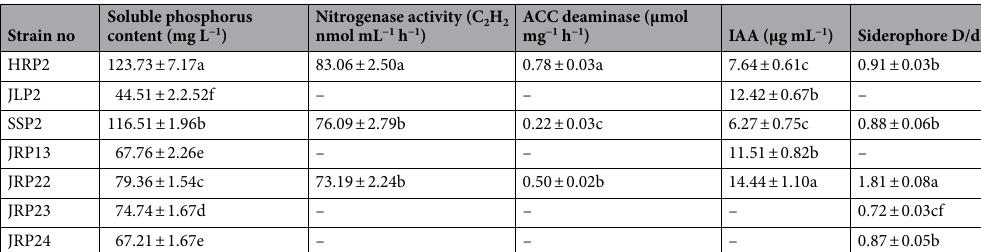
Table 5. Determination of the growth-promotion ability of phosphate-solubilizing bacteria. ACC 1-aminocyclopropane-1-carboxylate deaminase, IAA indole-3-acetic acid. Significant differences among the seven bacterial strains for each growth promotion indicator were determined using one-way analysis of variance at p < 0.05. The data are shown as mean ± SD (n = 3). Different lowercase letters represent significant differences among strains isolated from Chinese fir at p <